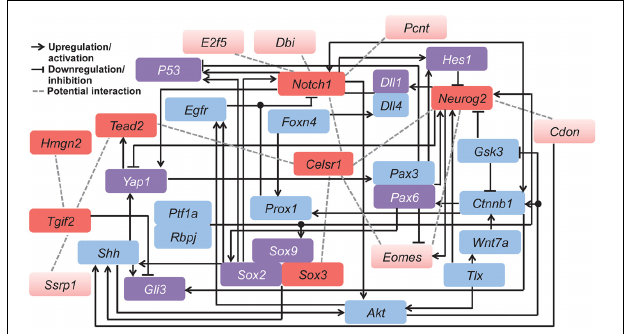
FIGURE 6 | Hypothetical functional gene network involved in regulating neocortical development. This model was derived by combining our candidate genes (red) with related genes (blue and purple) known from published mammalian cell line or animal studies. Among all candidates, the seven genes conserved in both the mouse and human networks are indicated in dark red, and those specific to the mouse network are in light red. Purple color indicates genes that overlap with the 407 genes from the human developing brain network. Different types of gene interactions are indicated by (1) black arrows: upregulation or activation; (2) black lines with flat end: downregulation or inhibition; (3) gray dashed lines: potential interaction. Table S6 contains details of the literature mining